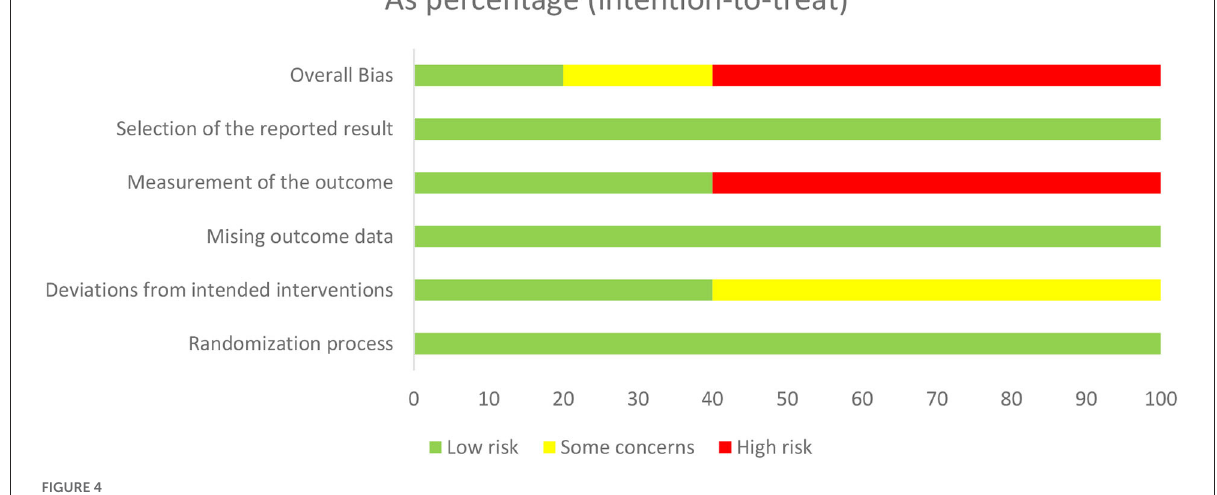
FIGURE4 Risk of bias of the included RCTs.